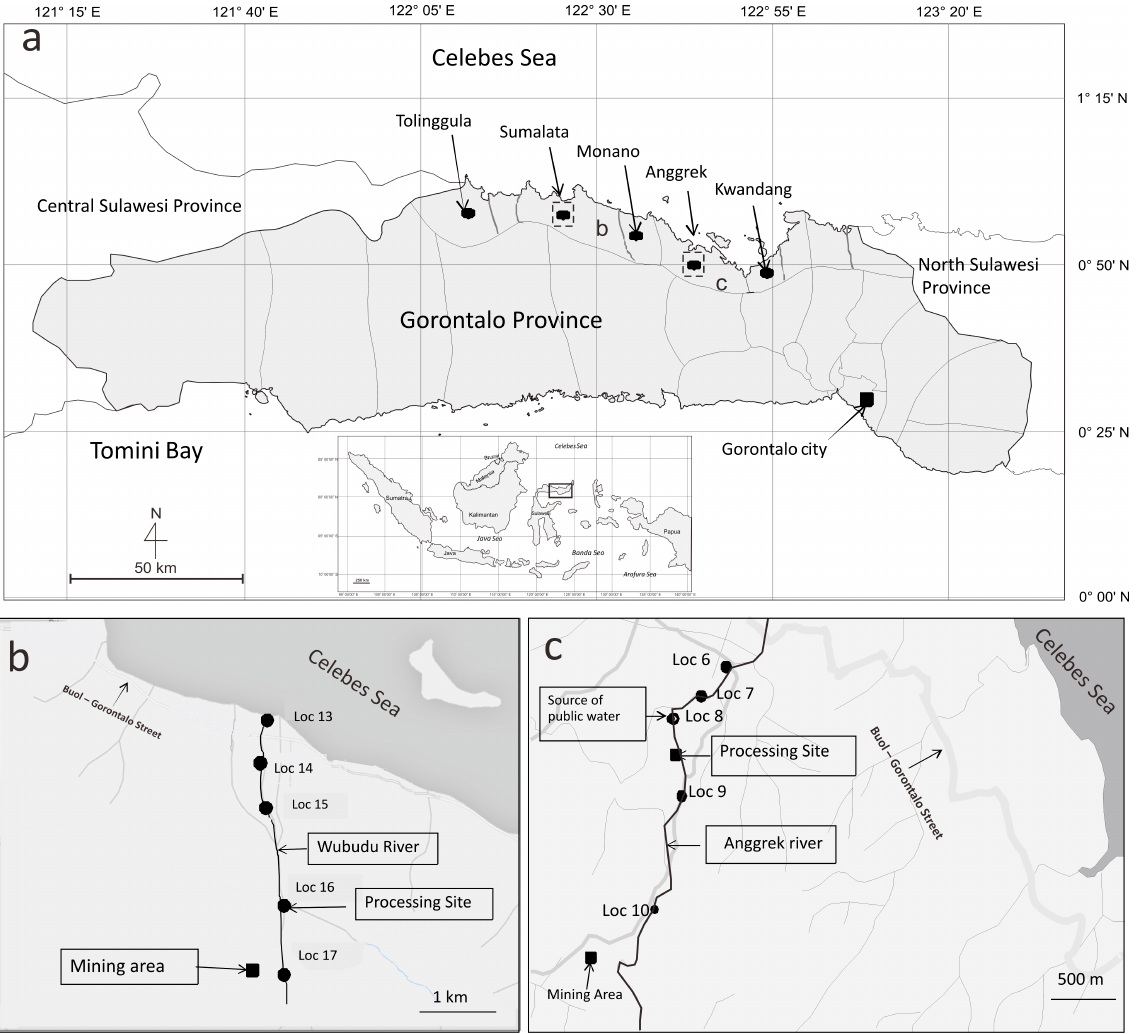
Figure 1. ( a ) Gorontalo Province map showing sampling locations ( ● ) of human hair from Gorontalo Utara Regency, showing Tolinggula Sumalata, Anggrek, Monano and Kwandang districts. Location of Gorontalo Province in Indonesian map is shown (inset). The two rectangular shapes are ASGM locations and sampling sites for sediments and fishes; ( b ) Map of Sumalata gold mining site, showing locations ( ● ) are sediment sampling sites and ( c ) map of Anggrek gold mining site, showing locations ( ● ) are sediment sampling sites. Information on locations of ASGM ore extraction and processing sites are given in the